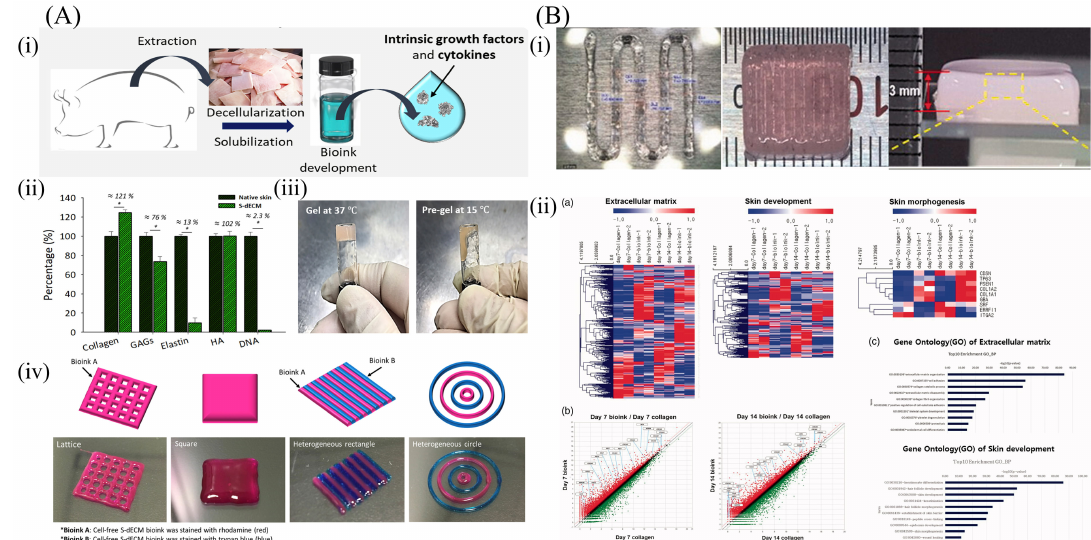
Figure 7. Two examples of skin-derived dECM bioinks for 3D printing applications. ( A ) Skin-derived bioink formulation and its properties analysis: (i) S-dECM bioink preparation process; (ii) quantitative analyses of dECM bioink, including collagen, GAGs, elastin, hyaluronic acid, and DNA; (iii) sol-gel transition of dECM bioink; and (iv) printability test of dECM bioink [142]; ( B ) Structure of the 3D-printed construct using skin bioink and gene expression: (i) cell-laden 3D scaffold; and (ii) changes in gene expression in the 3D-printed cell-laden construct